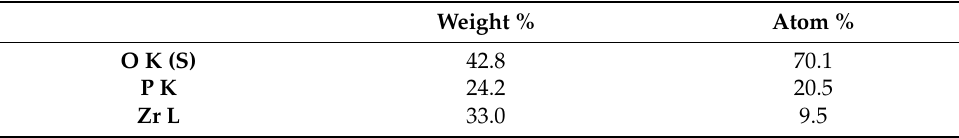
Table 1. Composition by EDX